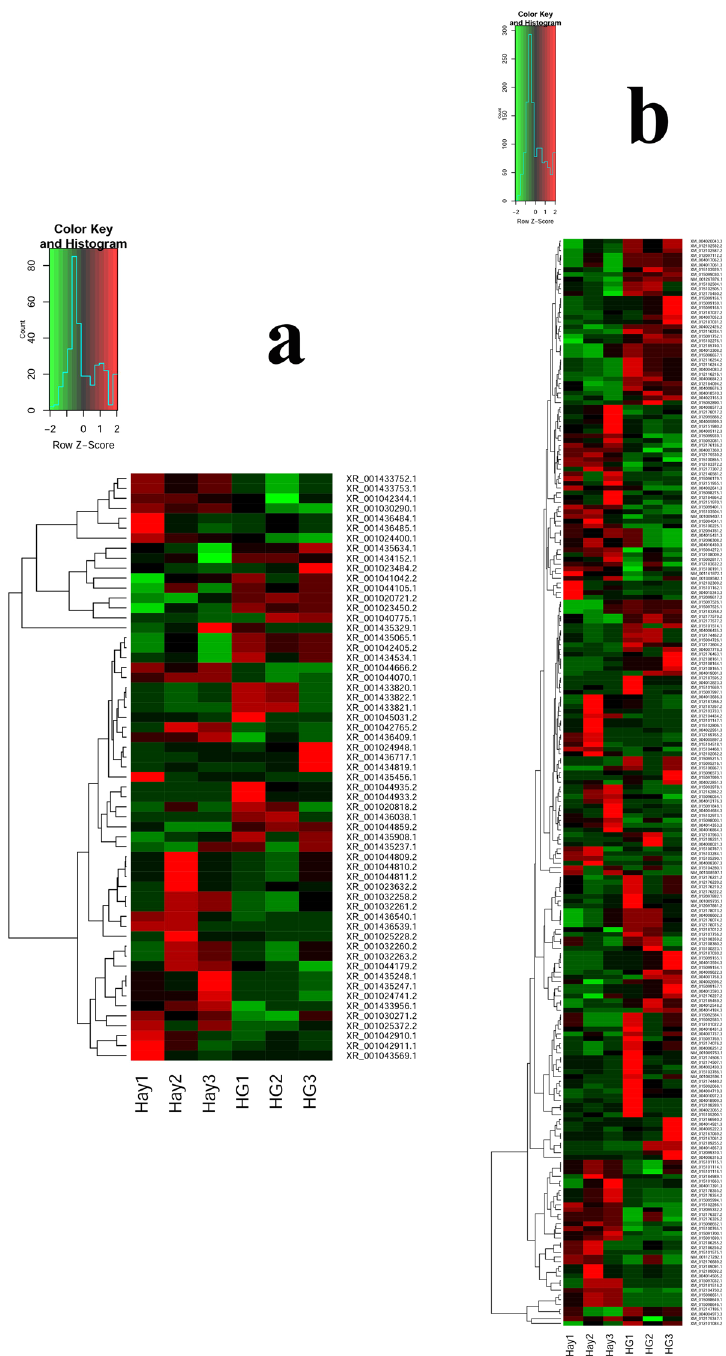
Figure 6. Heat maps illustrating the DE of lncRNA and mRNA between the hay and the HG diet groups. ( a and b ) show 59 DE lncRNAs and 229 DE mRNAs, respectively; green indicates downregulation and red indicates